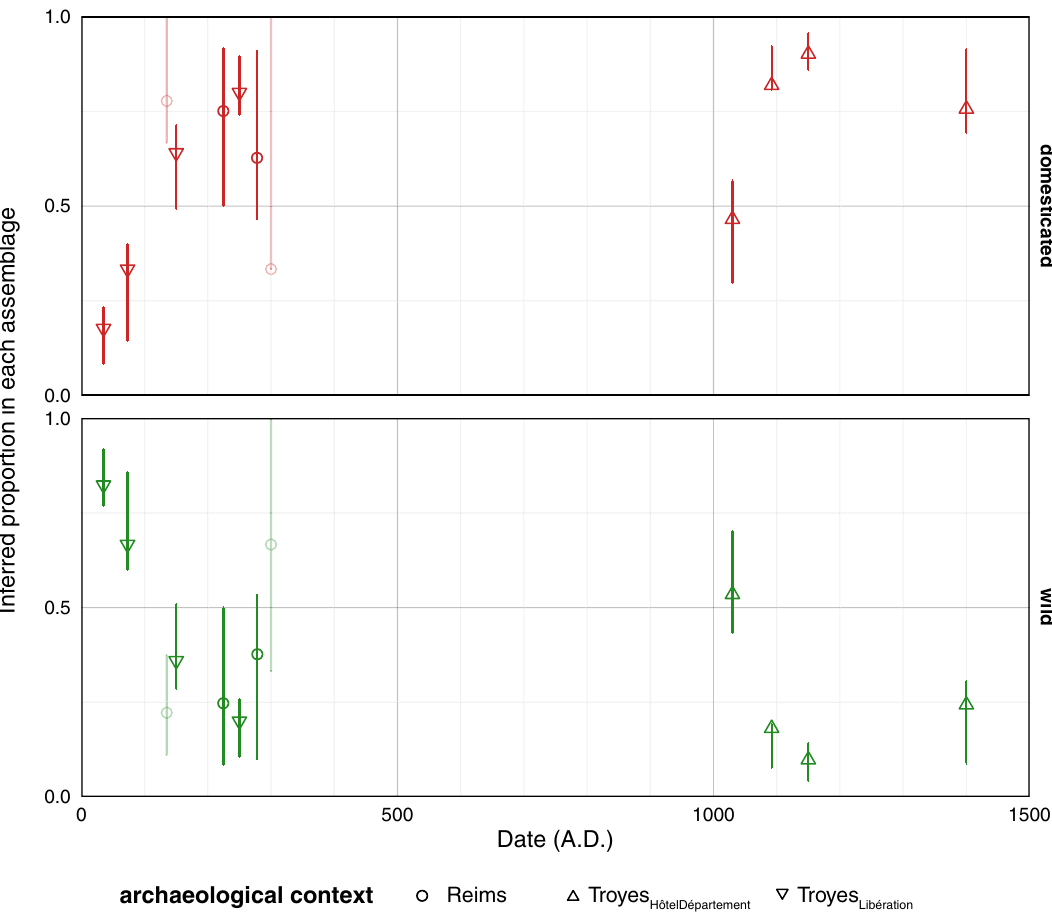
Figure 2. Inferred dynamics of the domesticated vs. wild type proportions. Identification were provided by LDA status and proportions are calculated within each assemblage. Observed proportions are indicated with a symbol, confidence intervals are obtained through 10 3 permutations, both are faded when sample sizes are